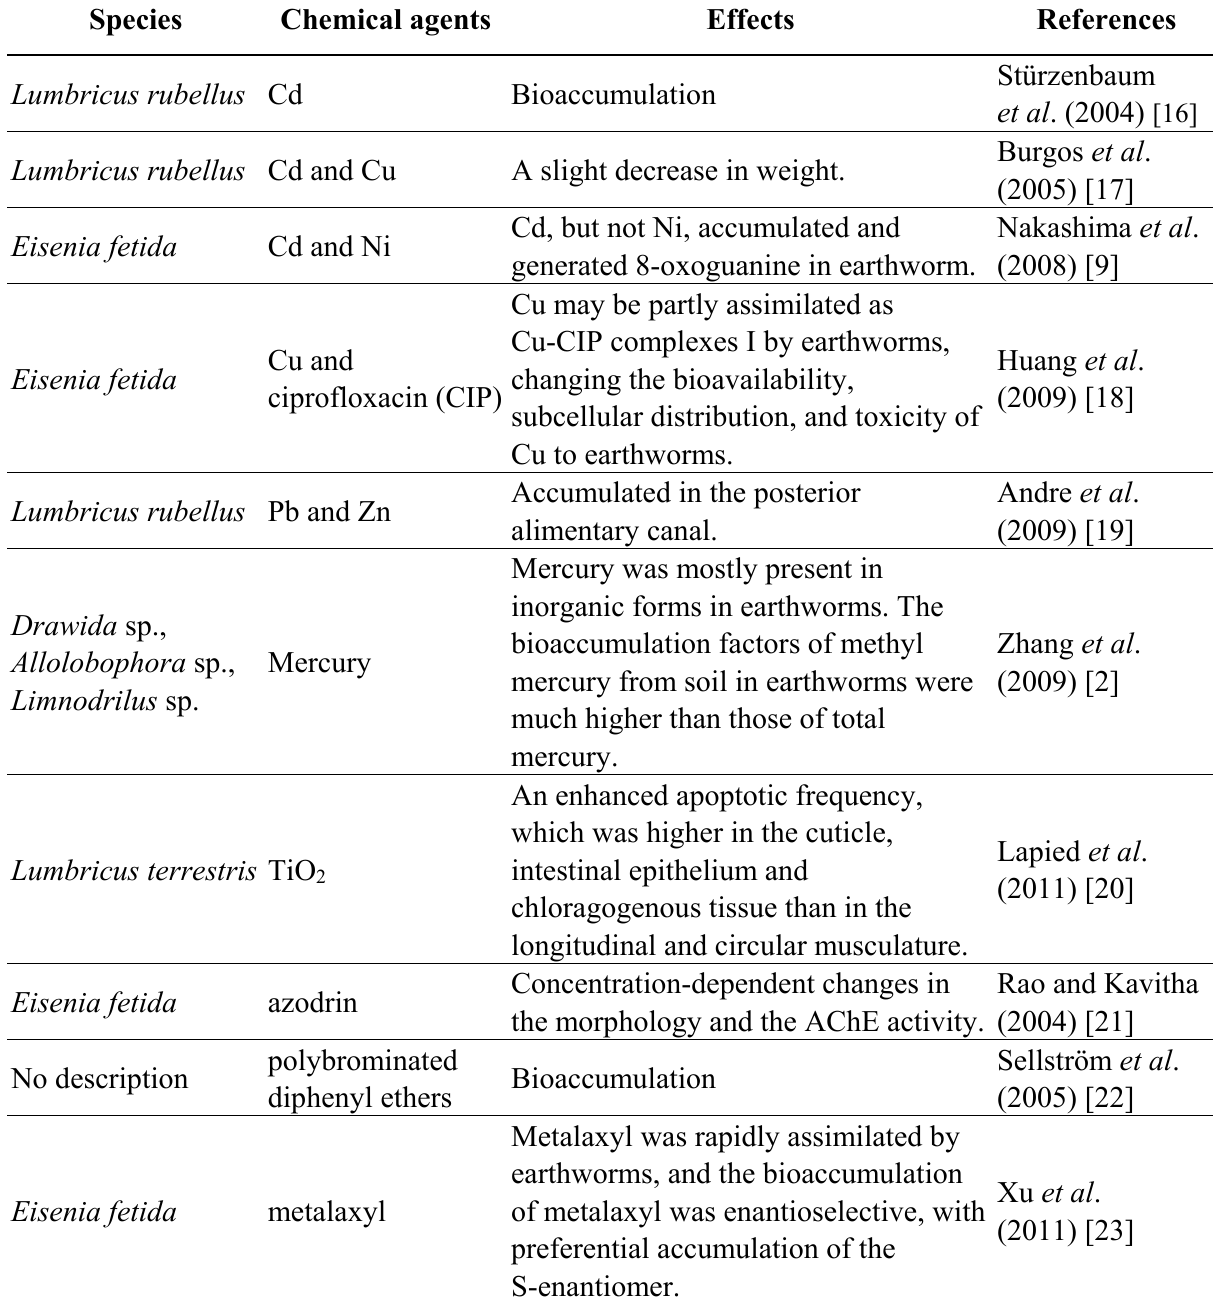
Table 1. Recent reports on the effects of chemical agents in